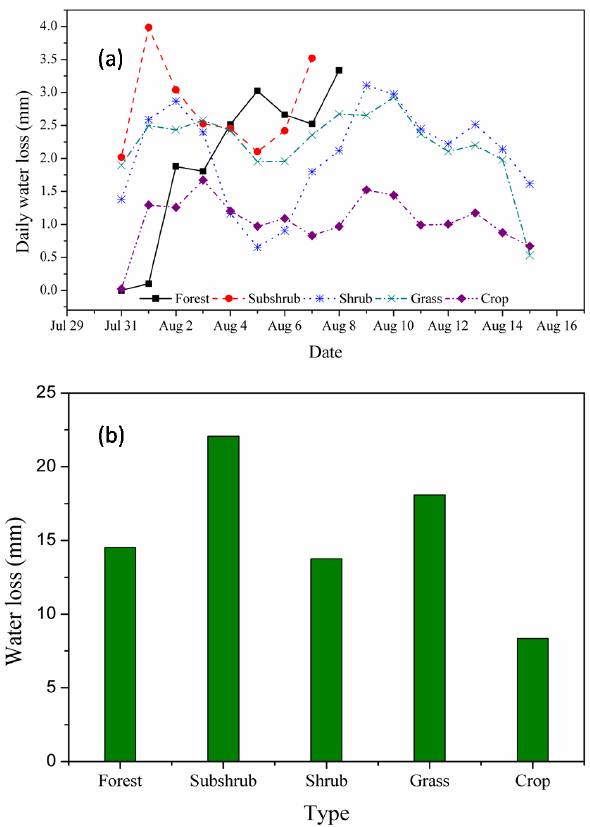
Fig. 7. Daily soil water loss (a) from 31 July to 15 August and cu- mulative water loss (b) under the five land cover types from 31 July to 7 August.